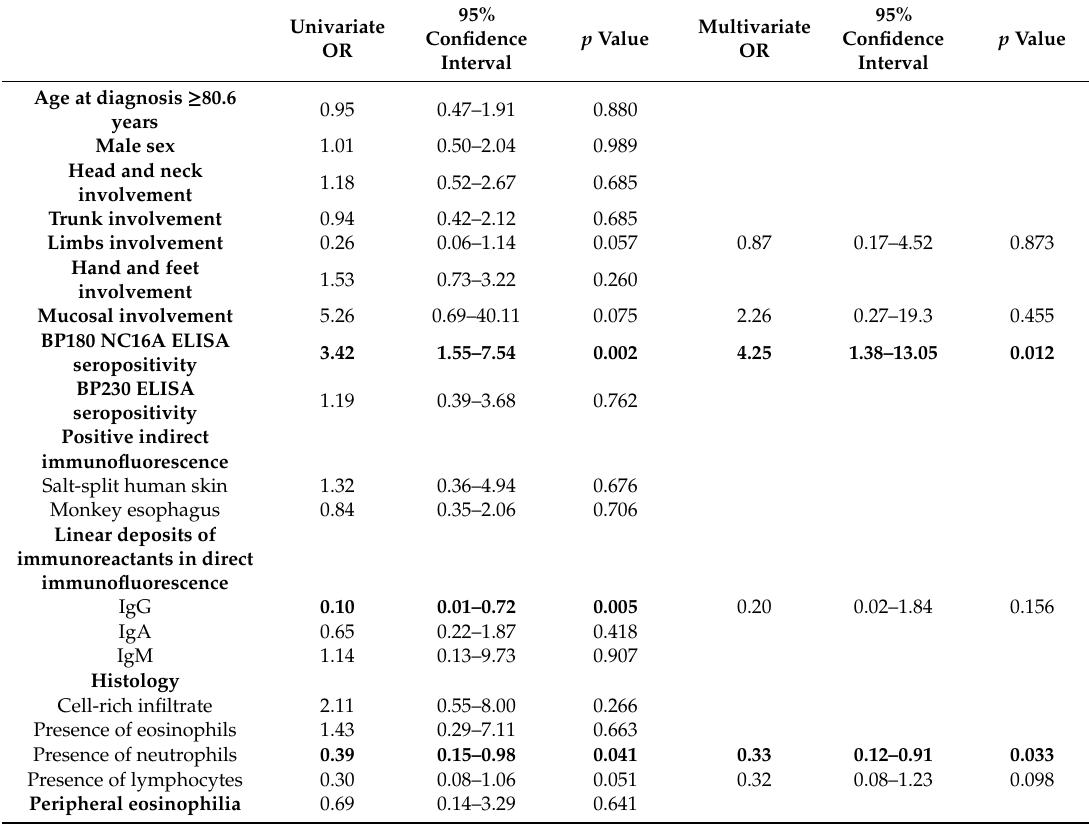
Table 3. Factors associated with C3 deposition by DIF as identified by logistic regression